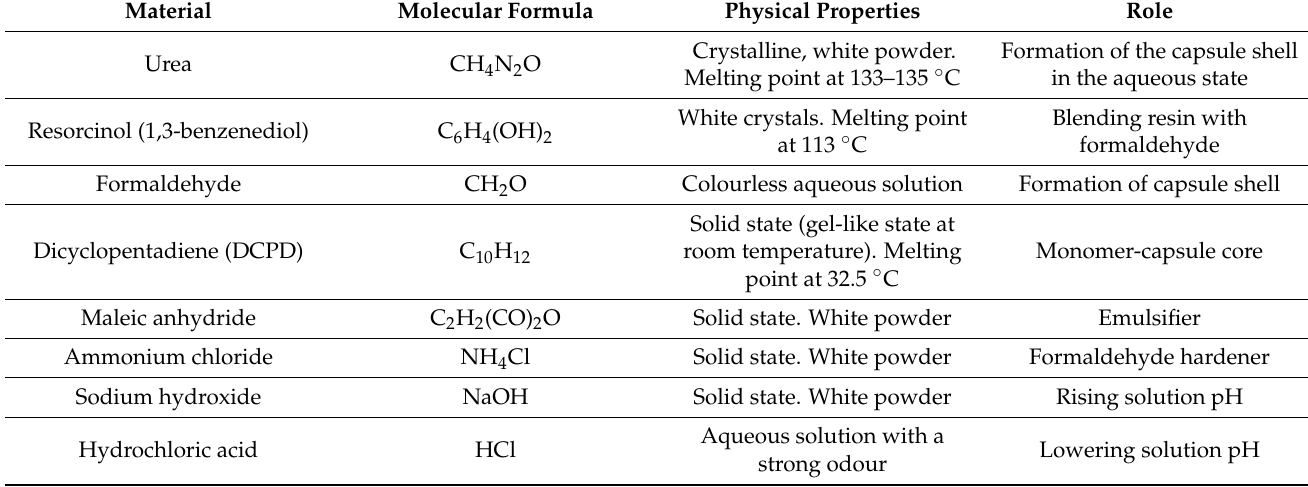
Table 1. Materials used in the synthetization of self-healing PUF-DCPD microcapsules.